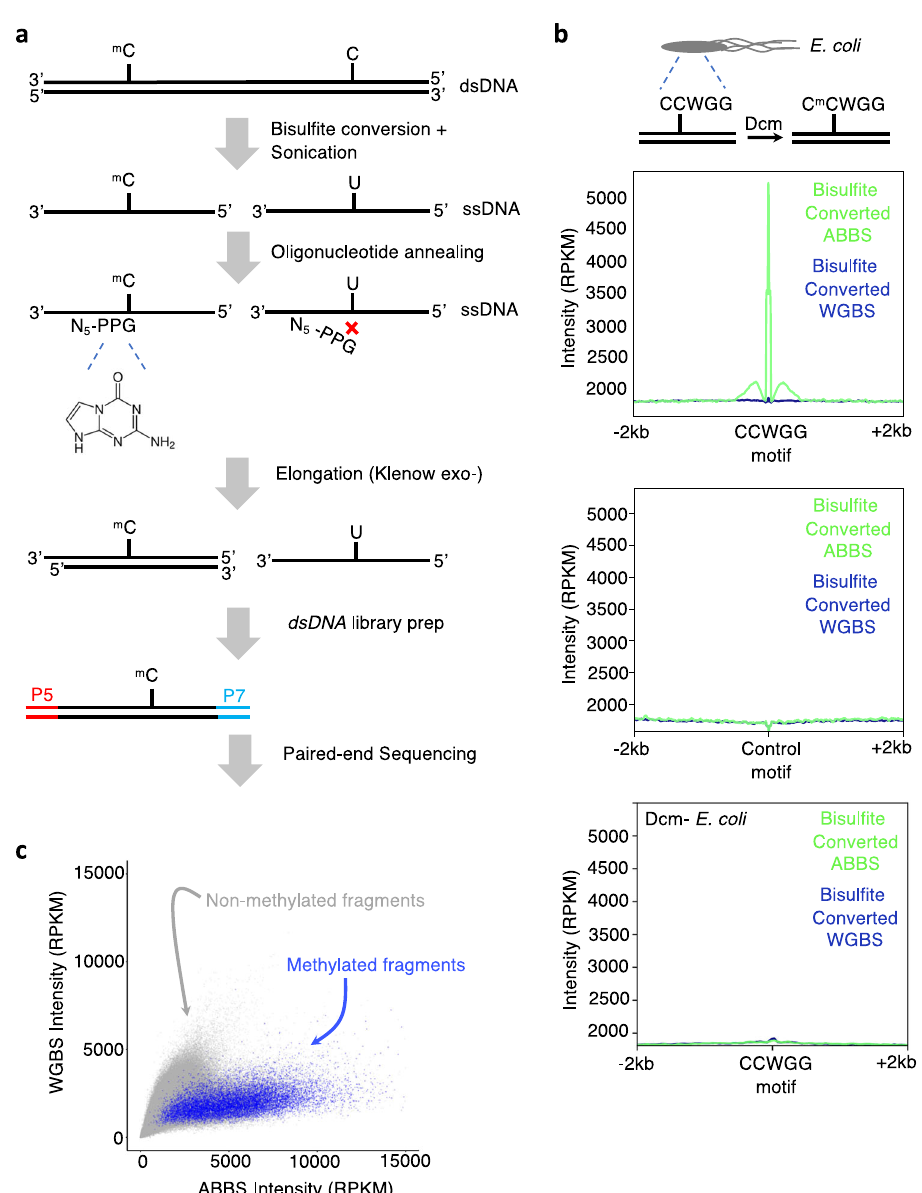
Fig. 1 ABBS detects 5mC in Escherichia coli . a Schematic of the ABBS approach. m C = methylcytosine. b ABBS sequencing reads accumulate at the CCWGG motif where methylation is expected. The distributions of ABBS and WGBS signals after bisul fi te conversion are shown around the Dcm methylase motif (CCWGG, top) and a control motif (AASTT, middle), or in a Dcm - E. coli B strain (bottom). m C = methylcytosine c ABBS offers increased coverage of 5mC sites. The WGBS and ABBS coverages are compared for each 10 bp bin over the E. coli genome. Methylated fragments are shown in blue and unmethylated fragments are shown in